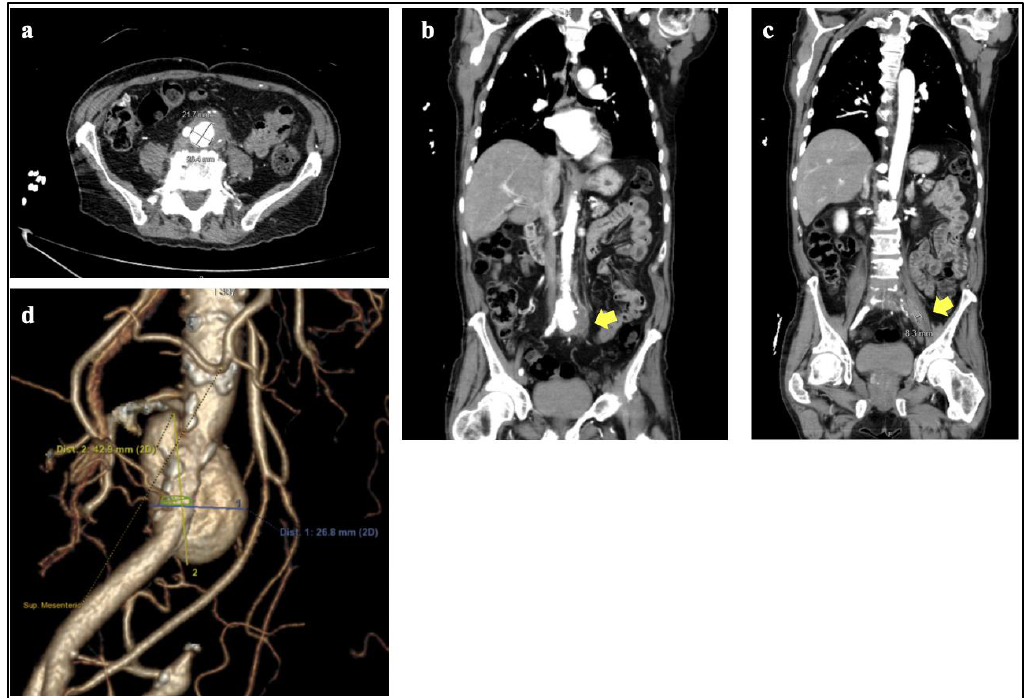
Figure 1. Mycotic aneurysm of abdominal aorta ( a ) Axial (with measurements) and ( b ) coronal images of periaortic soft tissue density surrounding saccular aneurysm. ( c ) Coronal image of periaortic soft tissue density extending into medial left psoas muscle. ( d ) CTA 3D reconstruction of saccular aneurysm with